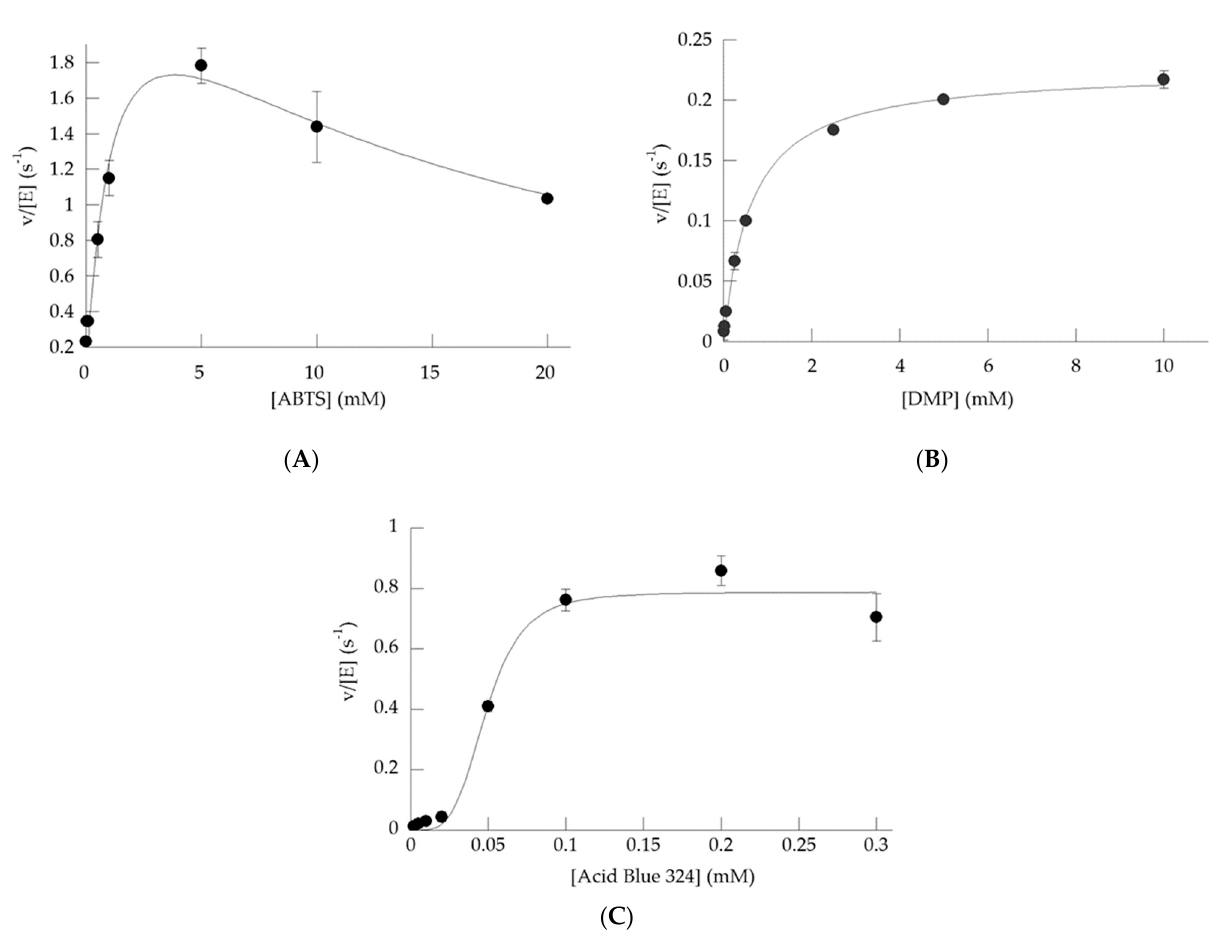
Figure 5. Substrate saturation curves of SaDyP1 for ( A ) ABTS at pH 4.5, ( B ) DMP at pH 4.0 and ( C ) Acid Blue 324 at pH 4.5 ( n = 3). The plots were fitted to Haldane equation (ABTS), Michaelis-Menten equation (DMP) and Hill equation (Acid Blue 324). Table 3. Kinetic parameters of purified SaDyP1 toward several